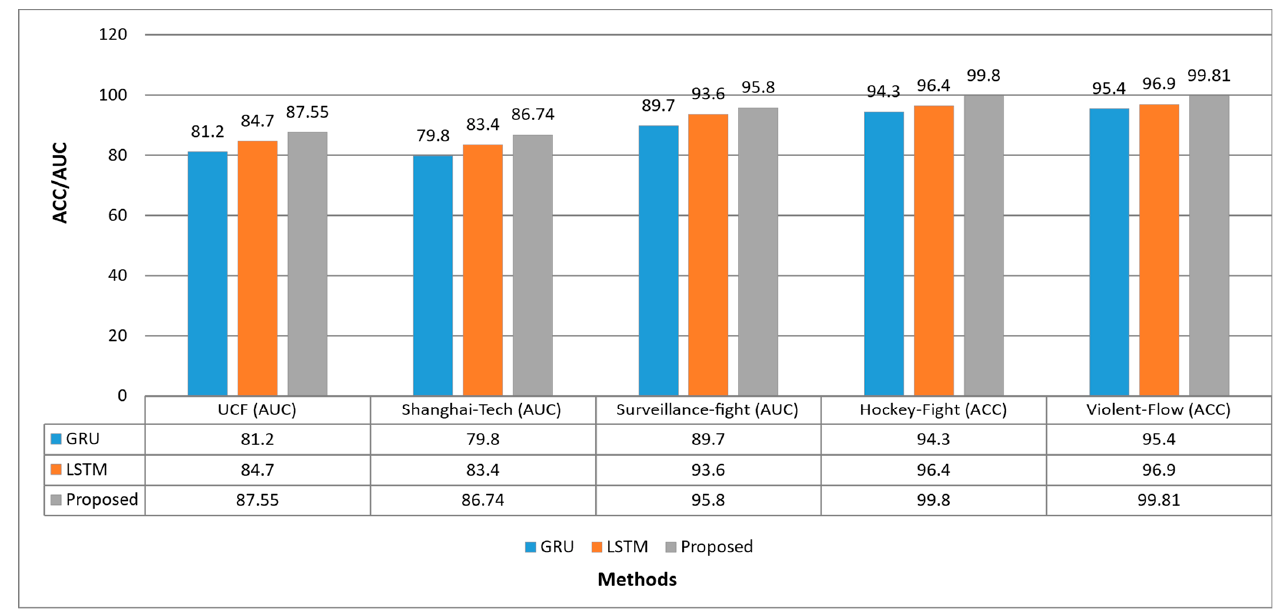
Figure 4. Performance comparison of the proposed model with ablation study methods.